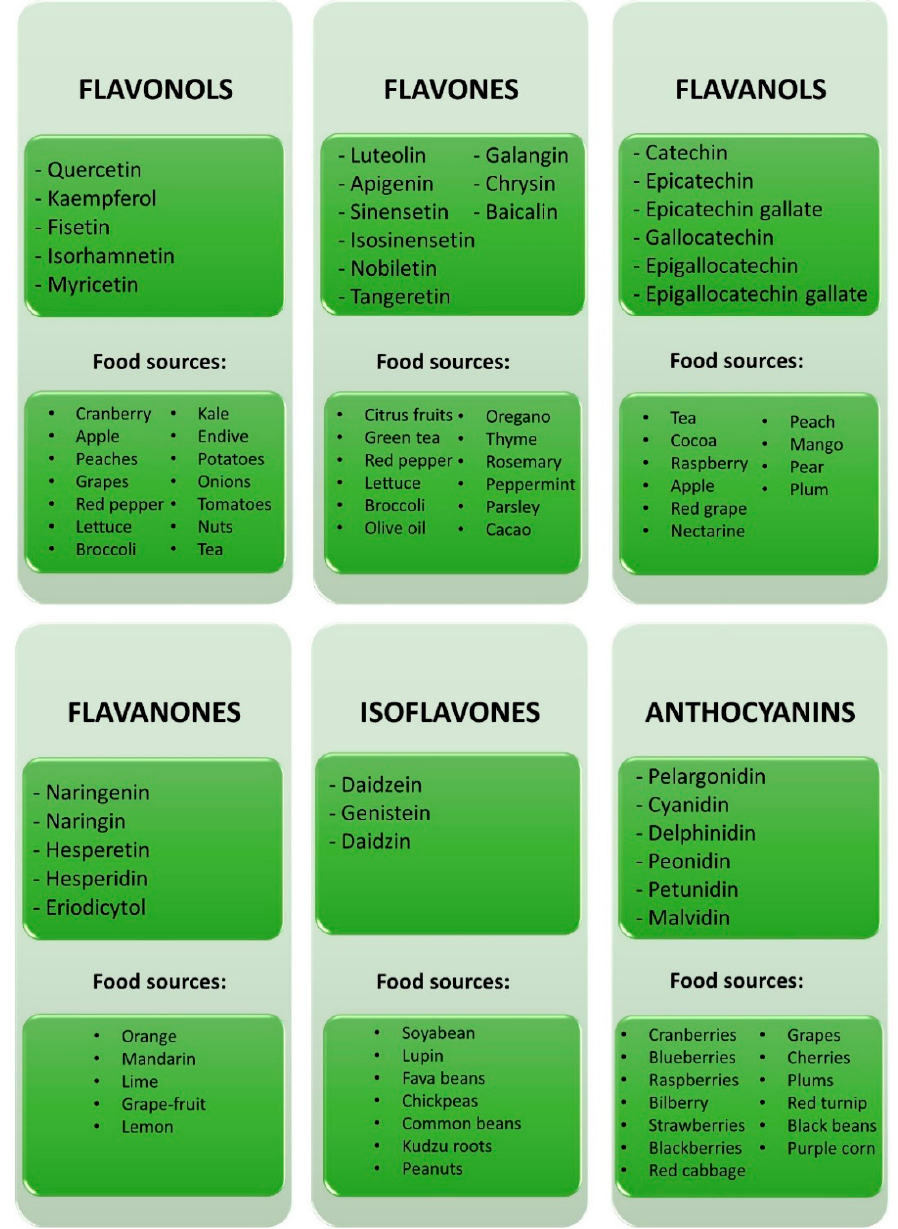
Figure 6. Flavonoid classes and examples of natural food sources.